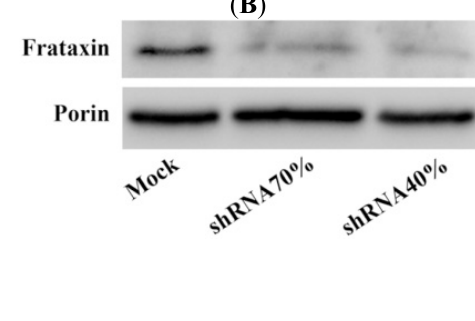
Figure 1. Efficiency of the frataxin shRNA. Proliferating NSC34 cells were transduced with lentivectors encoding for shRNA sequences against murine frataxin (shRNA 70% and shRNA 40%) or containing only the GFP reporter gene and a shRNA non silencing insert (mock control). ( A ) The level of frataxin mRNA was quantified by RT-PCR. The results were expressed as percentage of the residual amounts of frataxin in respect to control mock-transfected cells; ( B ) Representative western blot of the frataxin protein level. Porin was used as the reference